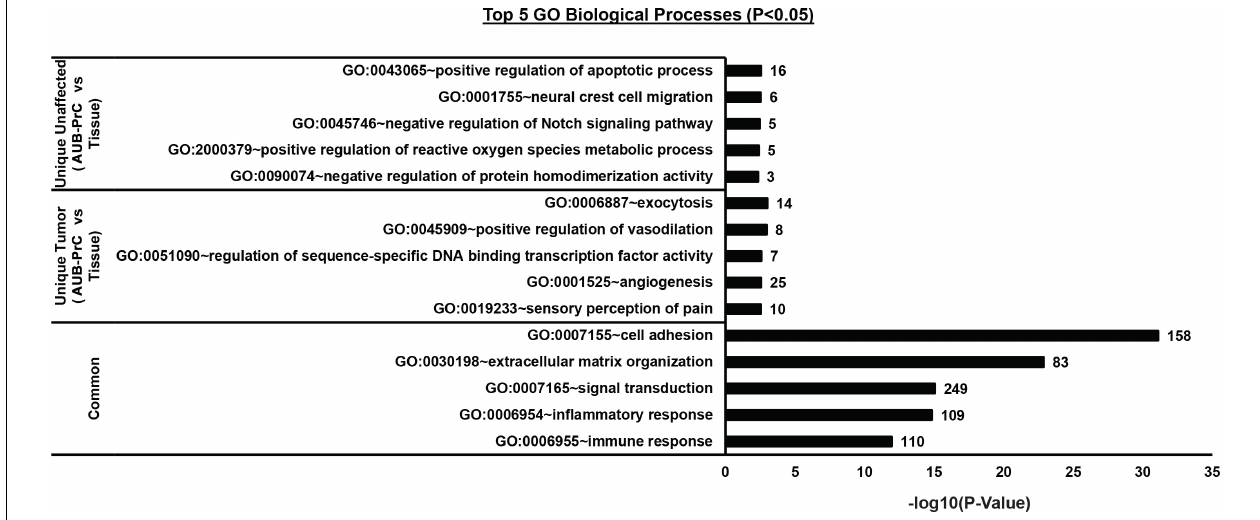
Frontiers in Cell and Developmental Biology |